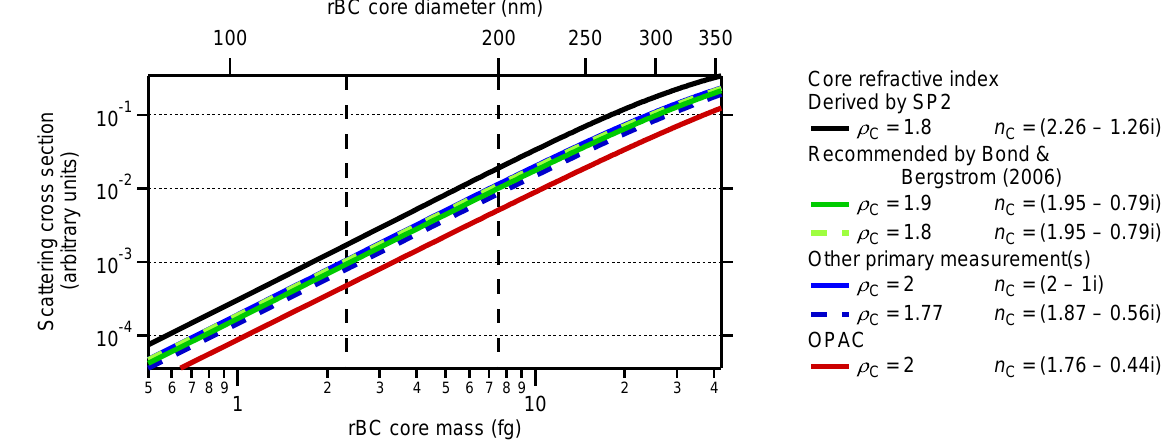
Figure 4. Calculated scattering cross-section, integrated over the angles of the SP2’s scatter detectors, for the different combinations of density and refractive index used in previous SP2 ambient core / shell modelling. Densities are in units of gcm − 3 . The vertical dashed lines bound the range of core diameter used for coating calculations in this study. The solid blue and dashed green lines partially